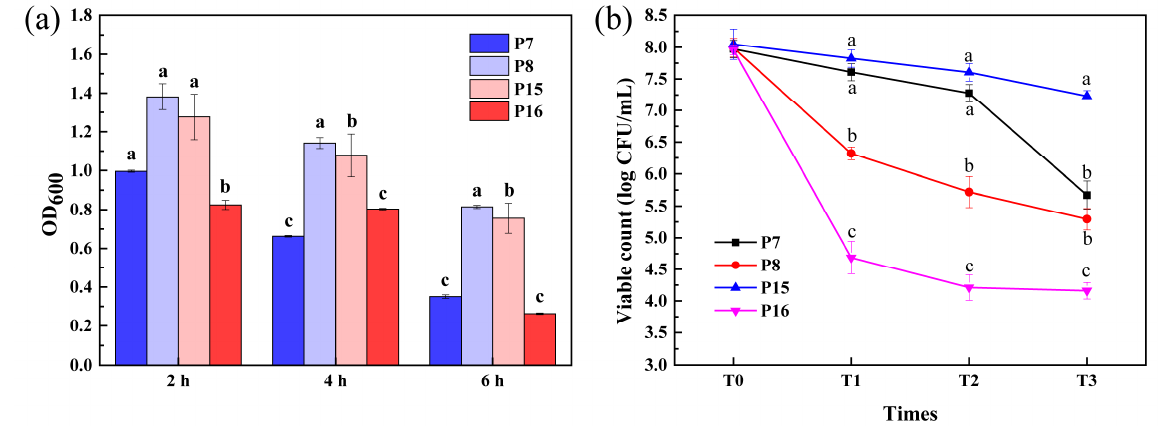
Figure 4. Survival of selected LAB strains in bile salt and simulated gastrointestinal fluids. ( a ) Biomass of four LAB isolates after 0.5% bile salt treatment, ( b ) viable count (log CFU/mL) of selected LAB strains after simulated GIT. Gastric juice T0 = viability at the beginning of gastric juice, T1 = viability after simulation of gastric conditions; intestinal juice T2 = viability at the beginning of gastric juice, T3 = viability after simulation of enteric conditions. Different lowercase letters (a, b, c) on the same row denote significant differences ( p < 0.05) during the assay, and results were expressed as mean ± SD ( n = 3).